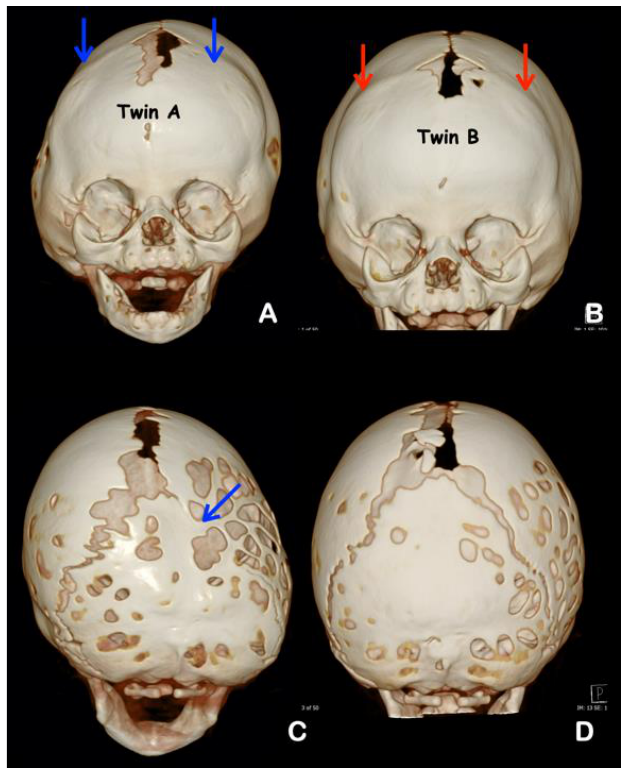
Figure 3. Radiographs and 3D CT reconstruction of twins A (A,C) and B (B,D). ( A ) Coronal synostosis (blue arrows) of twin A. ( B ) Coronal synostosis (red arrows) of twin B. ( C ) Note the cra- niolacunia of twin A. Lambdoid synostosis (blue arrow) and ipsilateral mastoid and contralateral parietal bossing with associated downward tilt of the cranial base toward the affected side. ( D ) Cra- niolacunia and patent lambdoid suture of twin B.